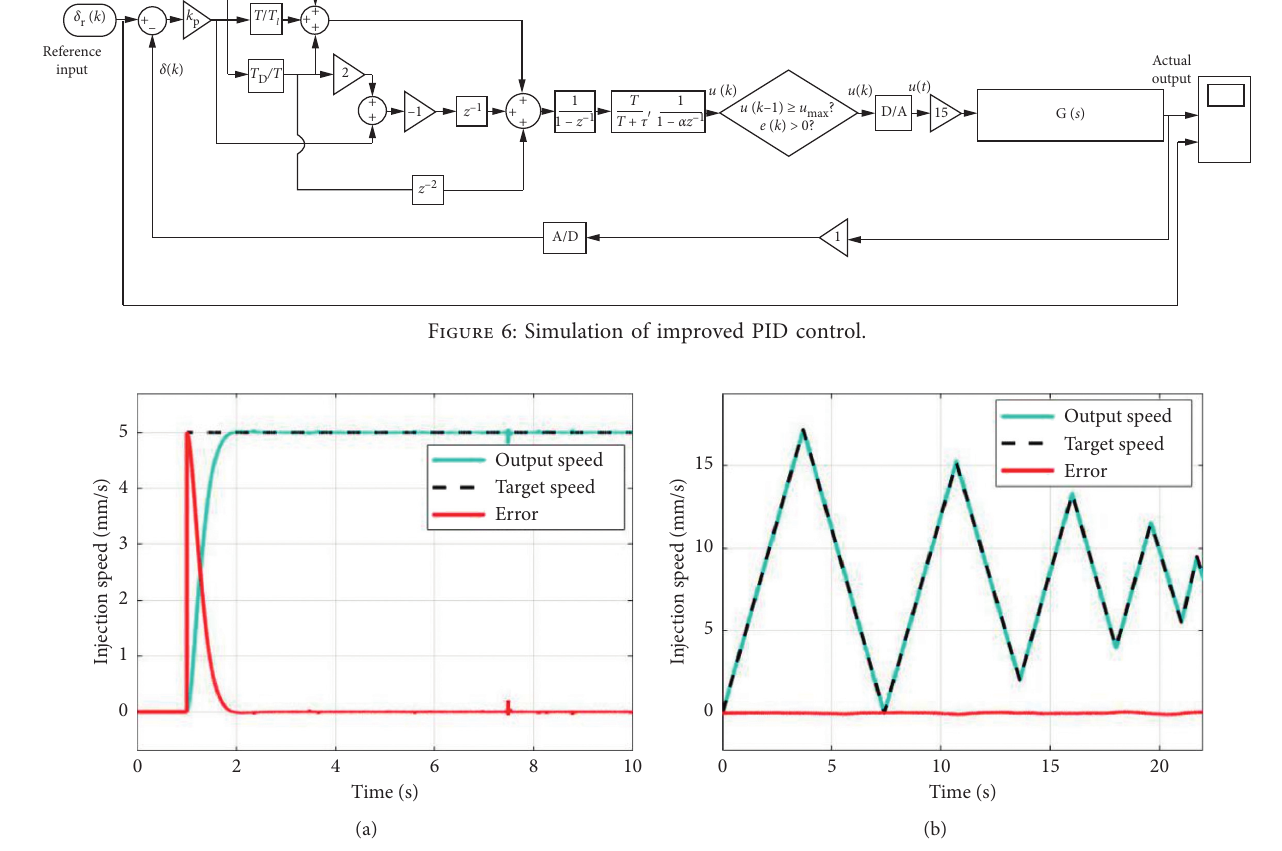
Figure 7: Improved PID simulation results. (a) Step response simulation. (b) Composite response simulation.